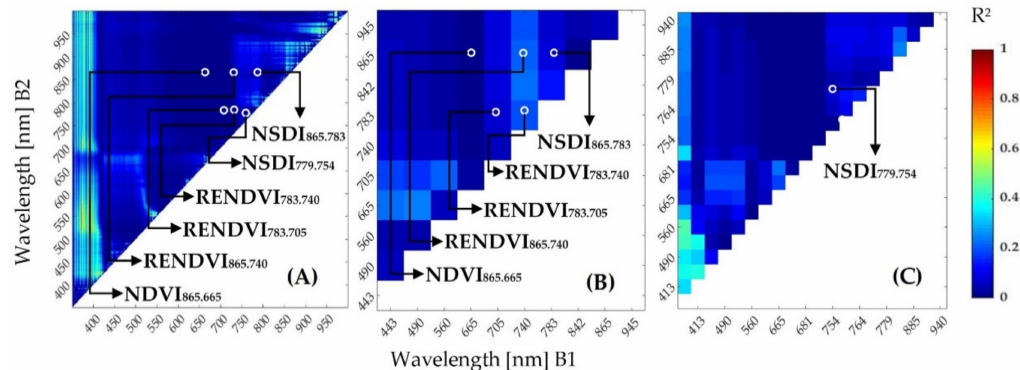
Figure 5. R 2 values based on linear regression between the normalized di ff erence of all two-band combinations and LAI for IT-MBo 2017 considering the spatial scale observations: ( A ) R 2 obtained using the hyperspectral data; and ( B , C ) R 2 obtained using S-2 and S-3 simulated bands, respectively. White circles refer to the position of the indices in the correlogram and arrows are indicating the name of the respective